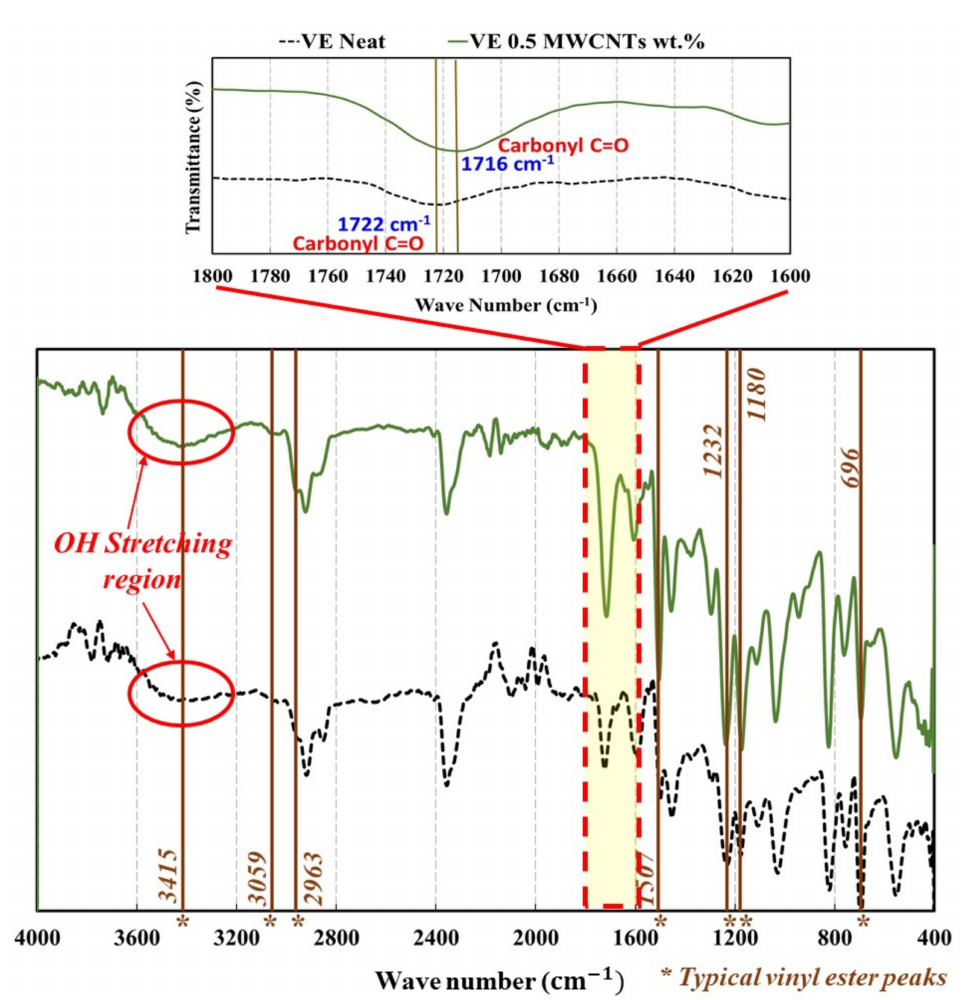
Figure 8. Fourier-transform infrared (FTIR) spectrogram showing bands observed for neat vinyl ester and vinyl ester incorporating 0.5 wt.%